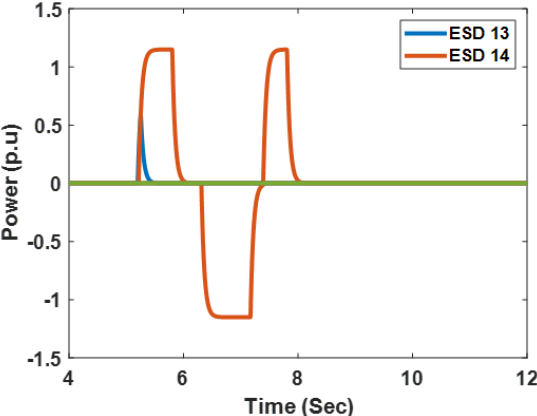
Figure 19. Speed of selected generators in the WNAPS.